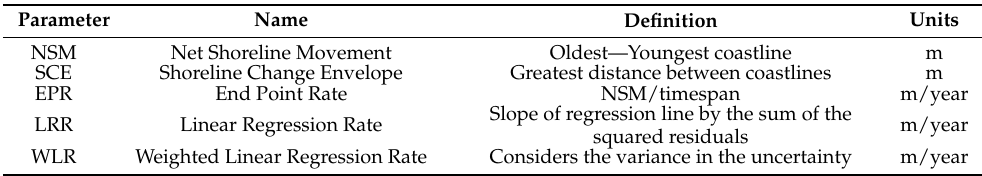
Table 2. Main statistical parameters calculated in the CoastCR